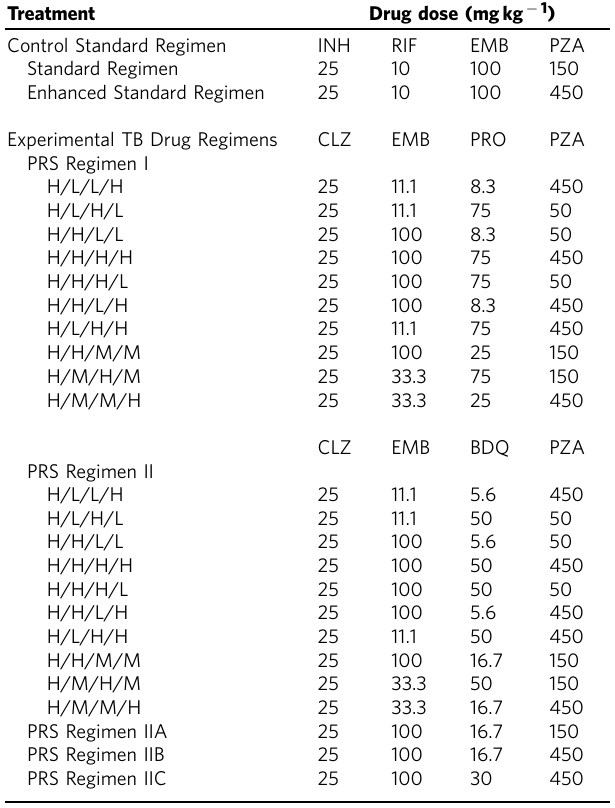
Table 1 | Drugs and drug doses used in the studies. Treatment Drug dose (mgkg (cid:2) 1